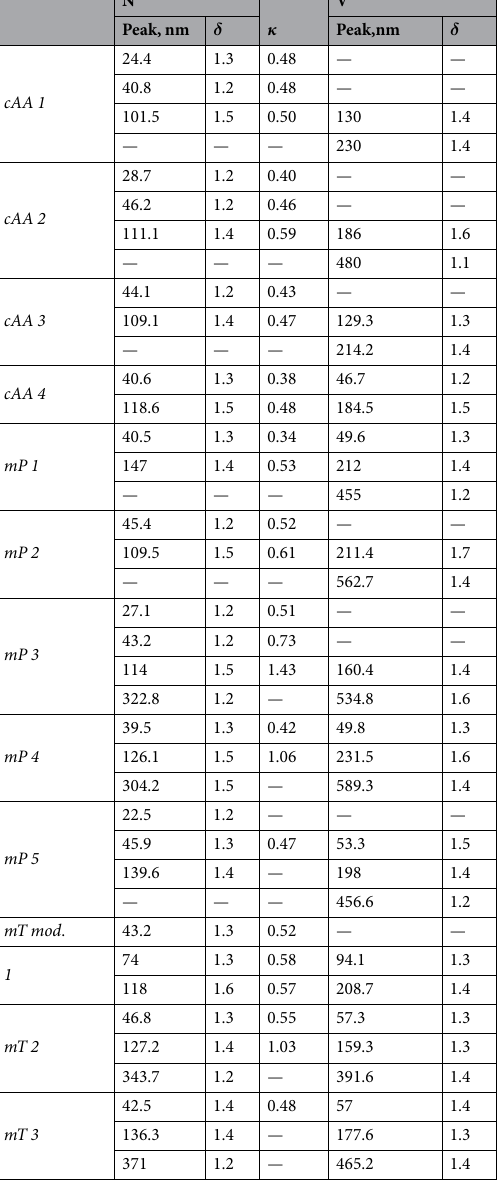
Table 3. Log-normal parameter fits for number and volume size distributions. Particle size, modal spread ( δ ), and ĸ for fitted number—size distribution peaks shown on left. Fitted particle volume peaks and spread shown on right. Dashed lines represent the lack of more peaks in the volumetric distributions. Missing ĸ-values indicate that lognormally fitted peak diameters were outside of sizes resolved by the